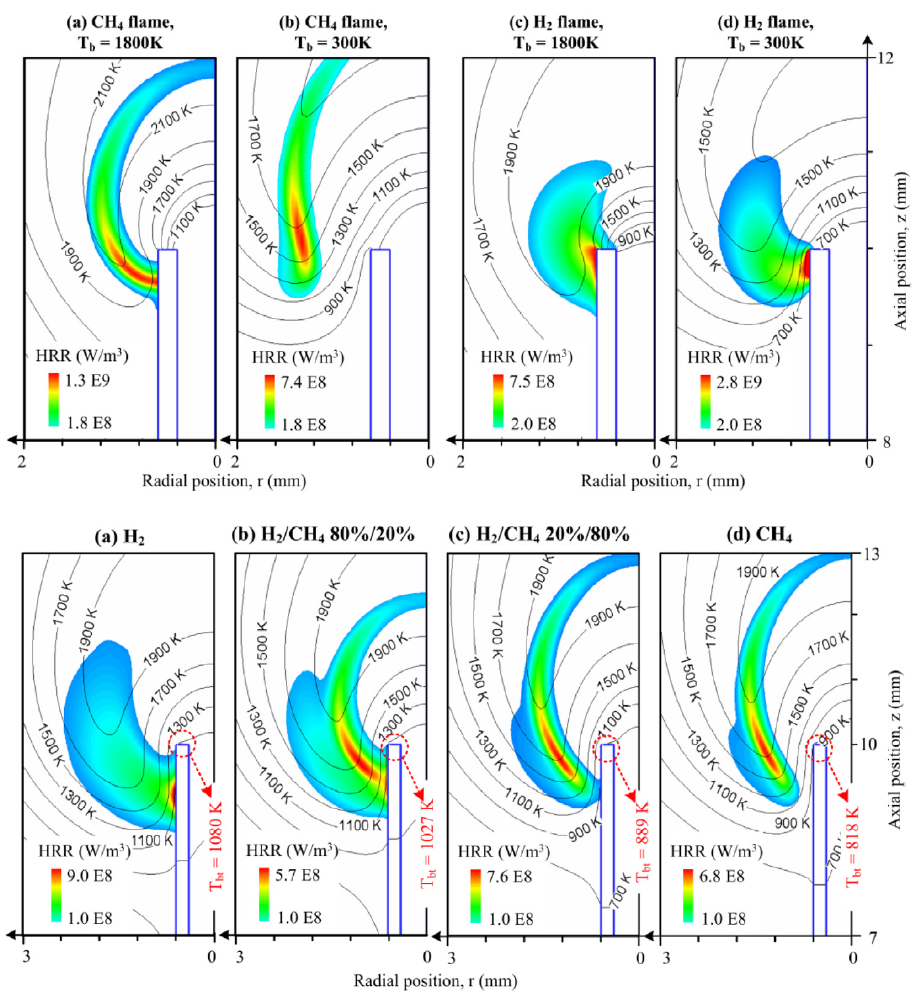
Figure 14. Numerical study of micro-jet hydrogen/methane diffusion flames by Gao et al. [27]. Top : Computed temperature contours and heat release rate (HRR) isopleths for CH 4 flames at fuel jet velocity of 0.4 m/s for ( a ) T b = 1800 K ( b ) T b = 300 K, and for H 2 flames at 1.0 m/s for ( c ) Tb = 1800 K ( d ) T b = 300 K; Bottom : Computed temperature contours and HRR isopleths at the thermal conductive burner condition (the thermal conductivity of burner wall is 16 W/m-K) for ( a ) H 2 flame at 2.0 m/s, ( b ) H 2 /CH 4 80%/20% flame at 1.2 m/s, ( c ) H 2 /CH 4 20%/80% flame at 0.6 m/s, ( d ) CH 4 flame at 0.5 m/s. Here the flame temperatures range between 2028 K and 2034